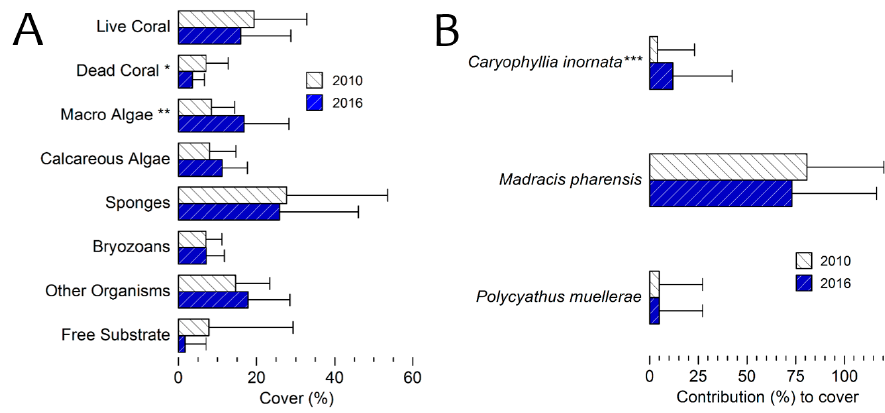
Figure 4. Percent benthic cover in 2010 and 2016 at the Cricket wreck according to ( A ) categories and ( B ) contribution (%) to coral cover of four species. * p = 0.03341; ** p = 0.007709; *** p = 0.04758.